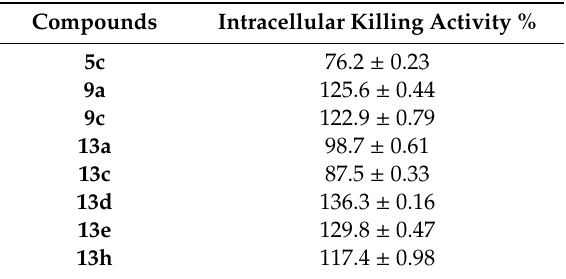
Table 3. The intracellular killing activities of active pyrazolopyrimidine